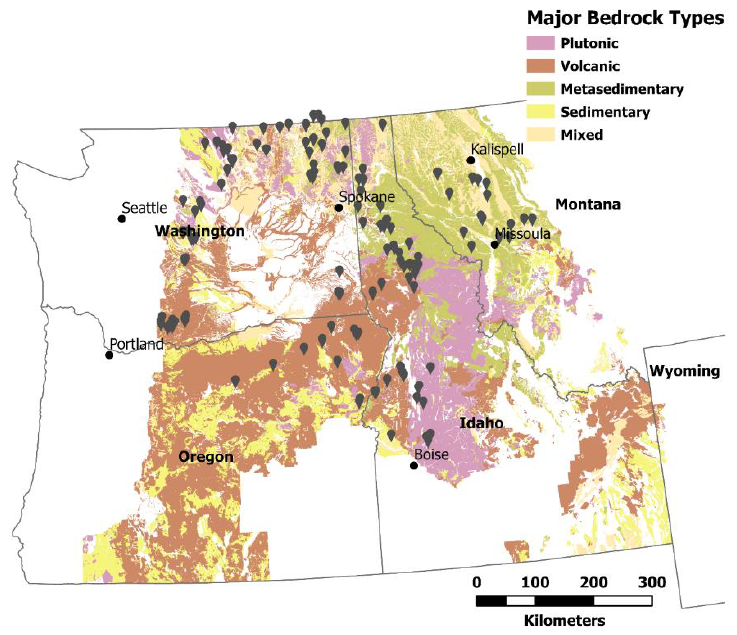
Figure 1. Major bedrock soil parent material distribution across the forested Inland Northwest, USA. Markers represent sampling locations used in this study. Table 1. Dominant lithologies found among broad geologic soil parent materials across the study